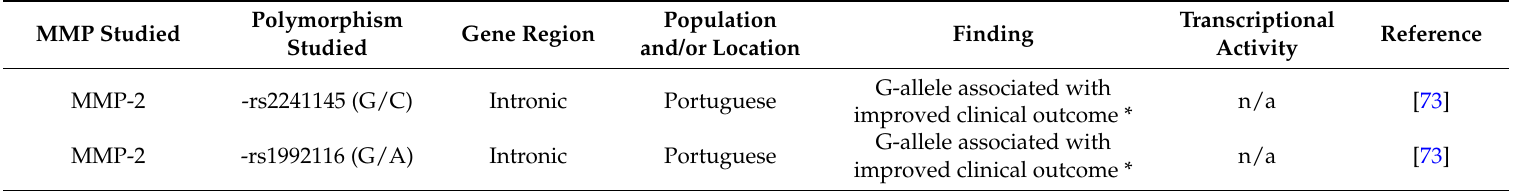
Table 3. MMP polymorphism relation to clinical outcome.